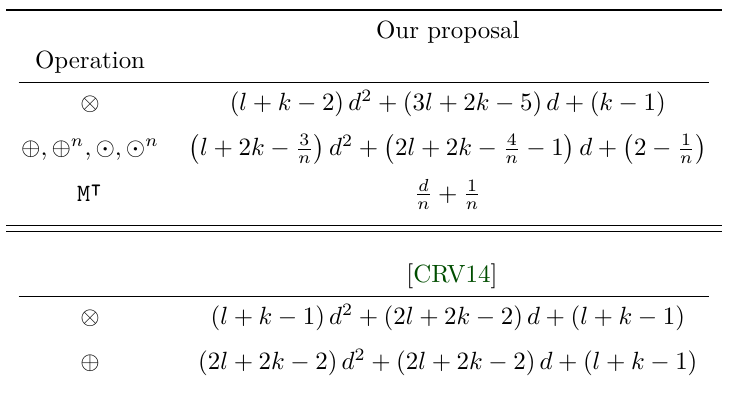
Table 2: Complexities of our proposal and the original method in terms of elementary